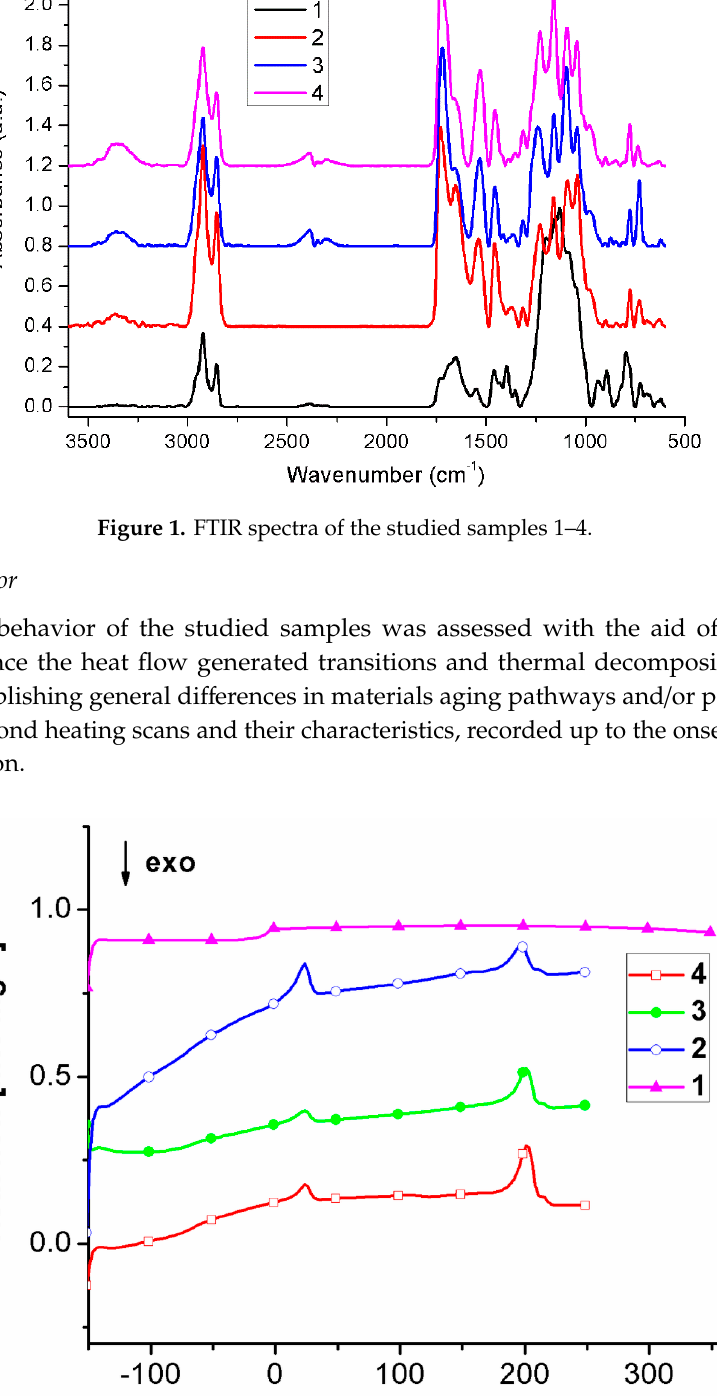
Figure 3. ( A ) TGA and ( B ) DTG curves of the studied samples. Table 1. Data evaluated from DSC measurements. Sample